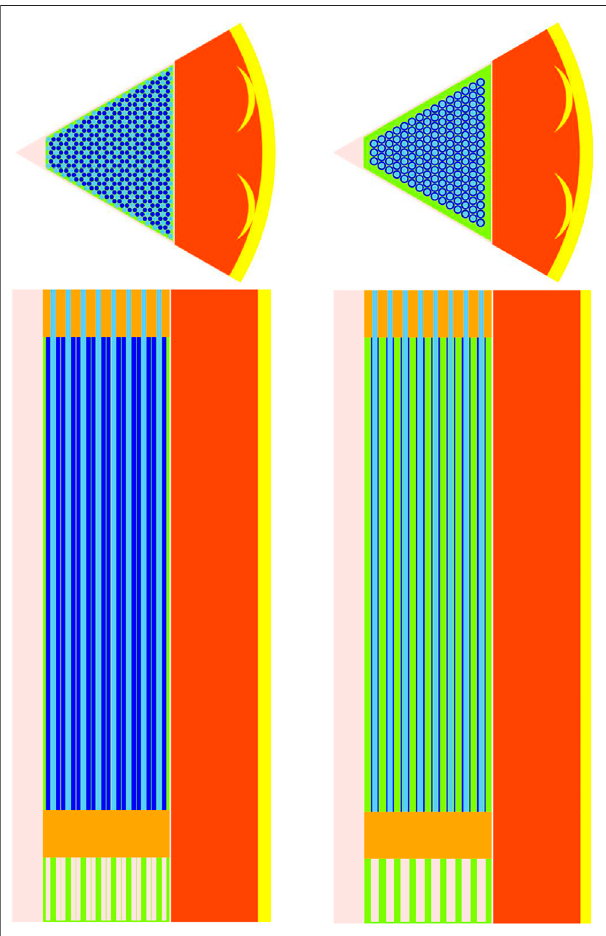
FIGURE 1 | The horizontal and vertical cross-sections of the one-sixth core design. The left is the original design of LANL (Sterbentz et al., 2017b). Therightistheheatpipedesignedwithannularfuel.Thedarkbluedenotesthe fuel. The light blue denotes the heat pipe. The green is the SS316. The orange is the re fl ector. The yellow denotes the